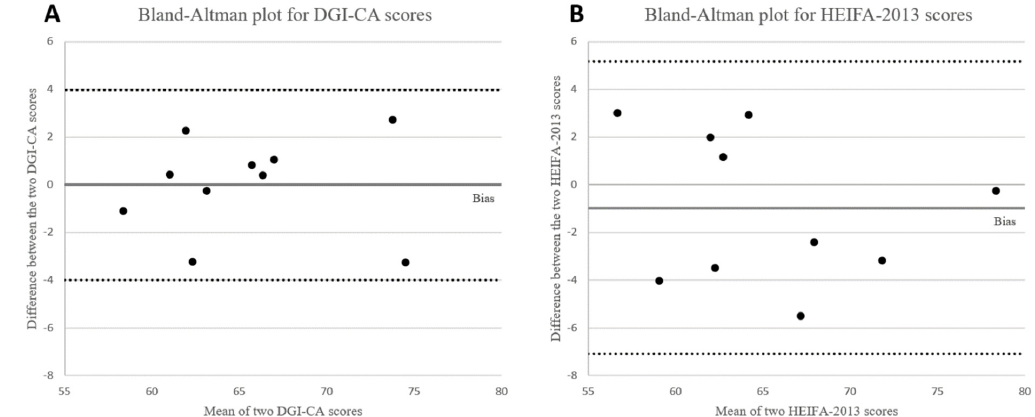
Figure 2. ( A ) Bland–Altman scatter plot for intra-rater reliability scores of the Dietary Guidelines Index for Children and Adolescents (DGI-CA) and ( B ) the Healthy Eating Index for Australian Adults (HEIFA-2013).